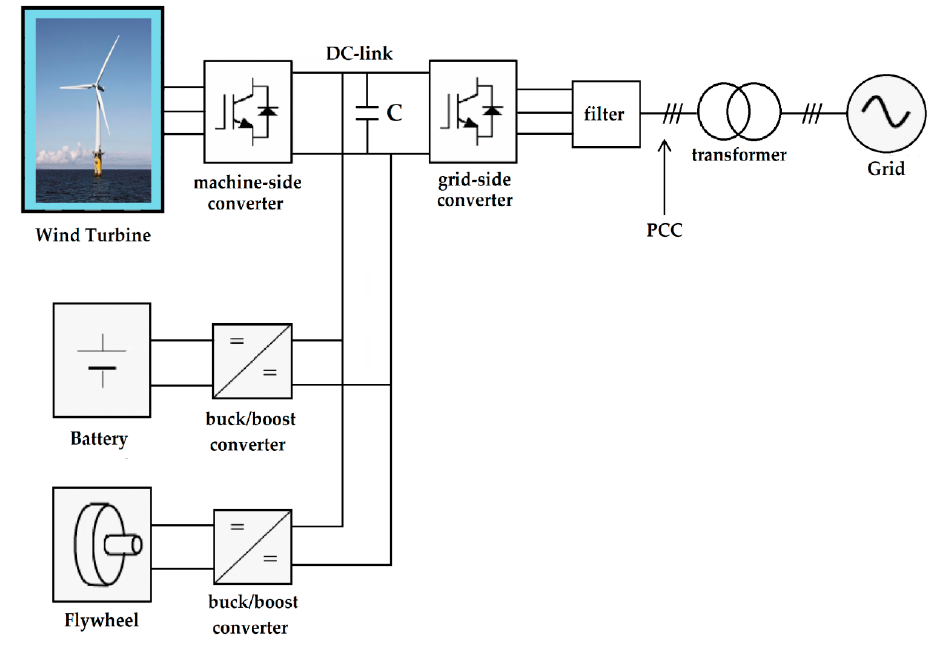
Figure 1. Schematic layout of the modeled system with HESS integration.